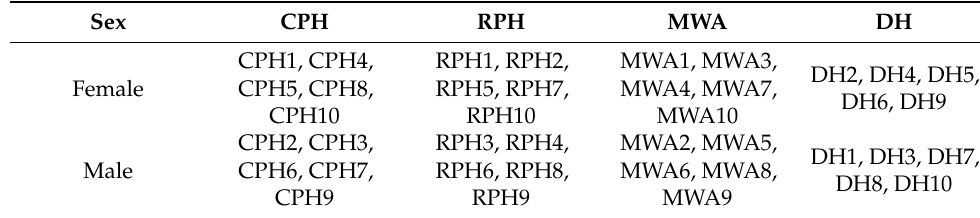
Table 1. The sex information of sampled